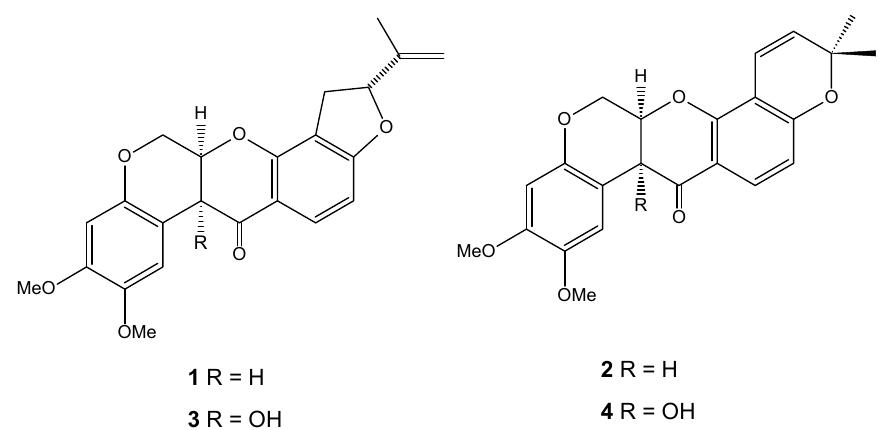
Figure 1. Structures of rotenoids: 1 rotenone, 2 deguelin, 3 rotenolone and 4 tephrosin.